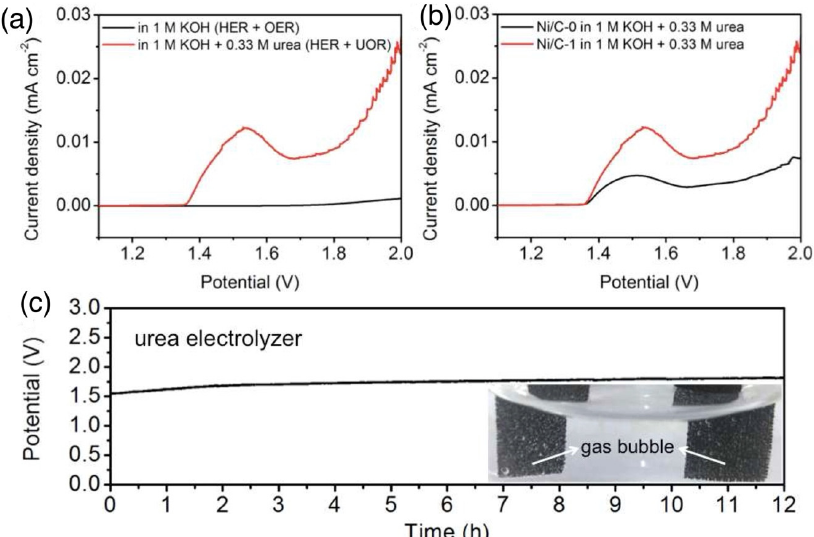
Figure 25. ( a ) LSV curves of an alkaline water electrolyzer and an alkaline urea electrolyzer using Ni/C-1 as a catalyst for both the HER and OER; ( b ) LSV curves of an alkaline urea electrolyzer using Ni/C-1 and Ni/C-0 catalysts; and ( c ) long-term durability tests of a urea electrolyzer. Inset: evolution of H 2 and N 2 gas. Reprinted with permission from Ref. [109]. Wang et al. [111] published a 3D composite of nickel nitride with reduced graphene oxide, Ni 3 N/rGO@NF, using various annealing temperatures; the electrode s-350 exhib-